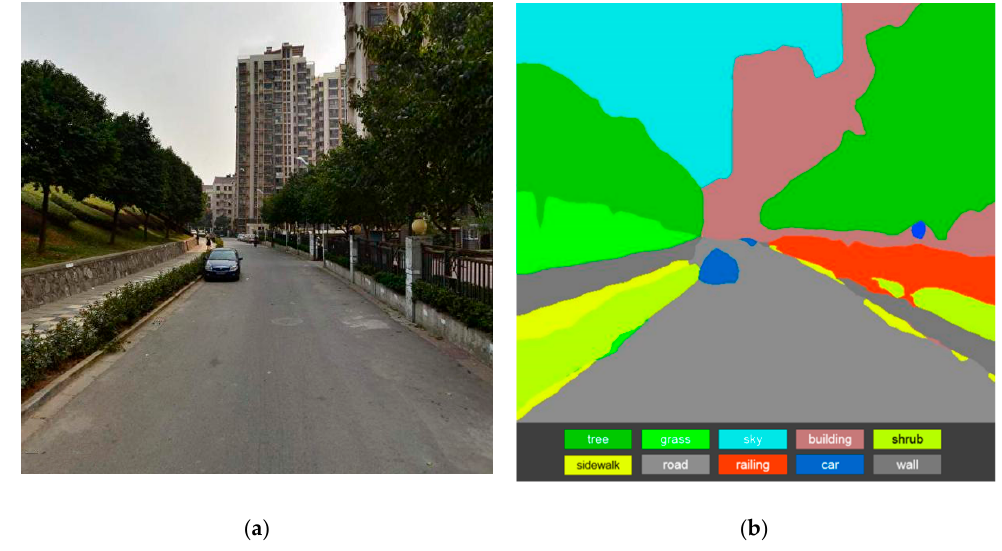
Figure 4. Image semantic segmentation result of a sample image. ( a ) The original street view picture. ( b ) The segmentation result by the Pyramid Scene Parsing Network (PSPNet) and corresponding categories.